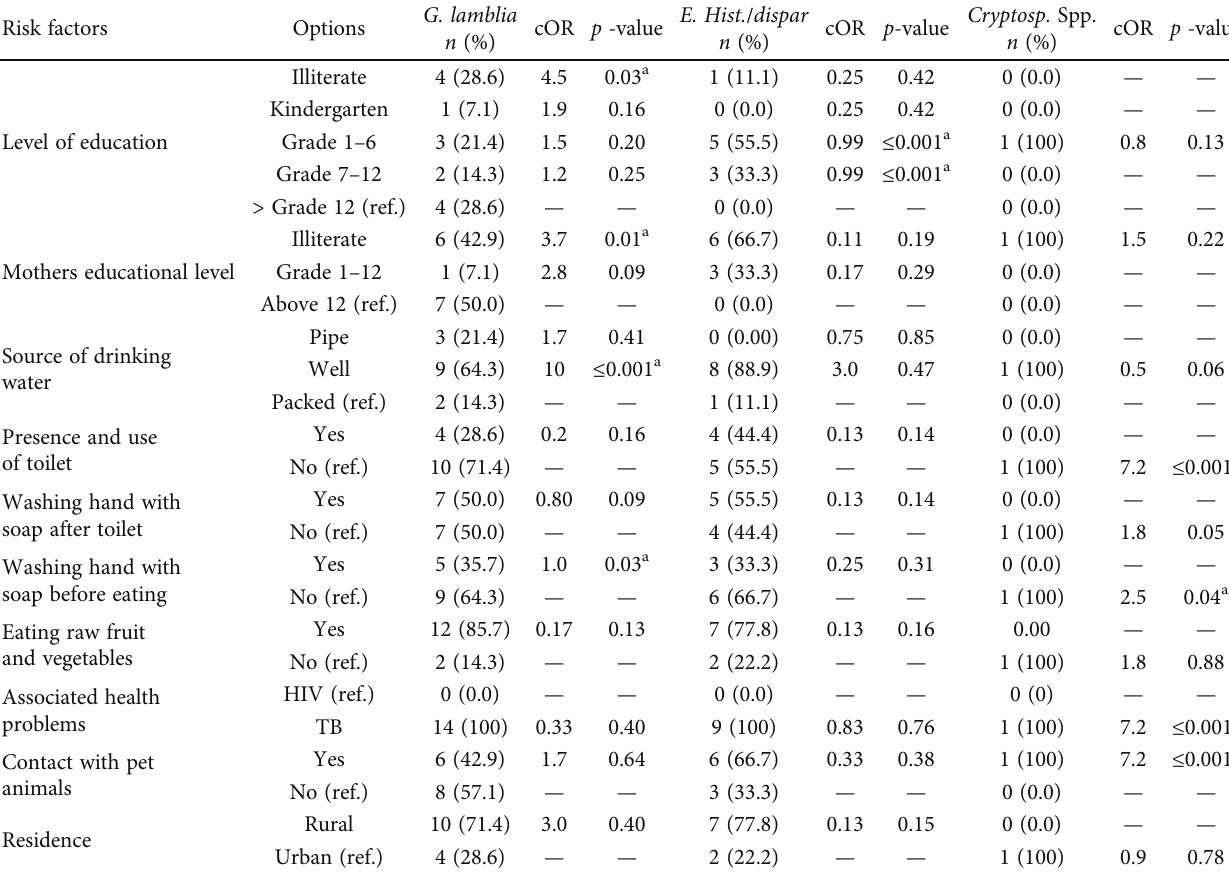
Table 5: Univariate logistic regression analysis for the associated risk factors of intestinal protozoal parasitic infection among positive diarrheal patients (cases) attending Negelle General